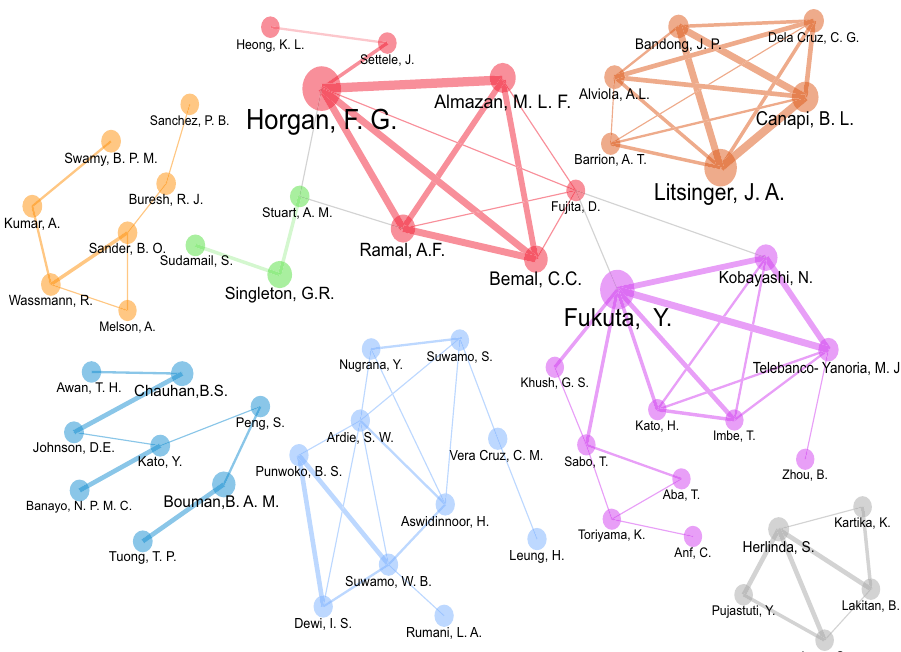
Fig. 3 Author collaboration networks, n = 80 authors. The authors ’ collaboration networks show eight major clusters of rice research in Indonesia and the Philippines.